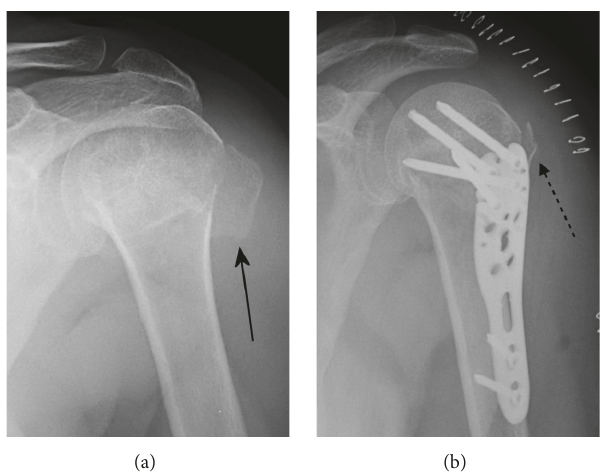
Figure 6: (a) Three-part varus impacted fracture with posterior displacement of the greater tuberosity (arrow) in a 55-year-old woman (AO/OTA type B1). (b) Nonanatomical reduction of the greater tuberosity (dotted arrow). The distortion of the normal bone morphology was minimal and did not influence the clinical